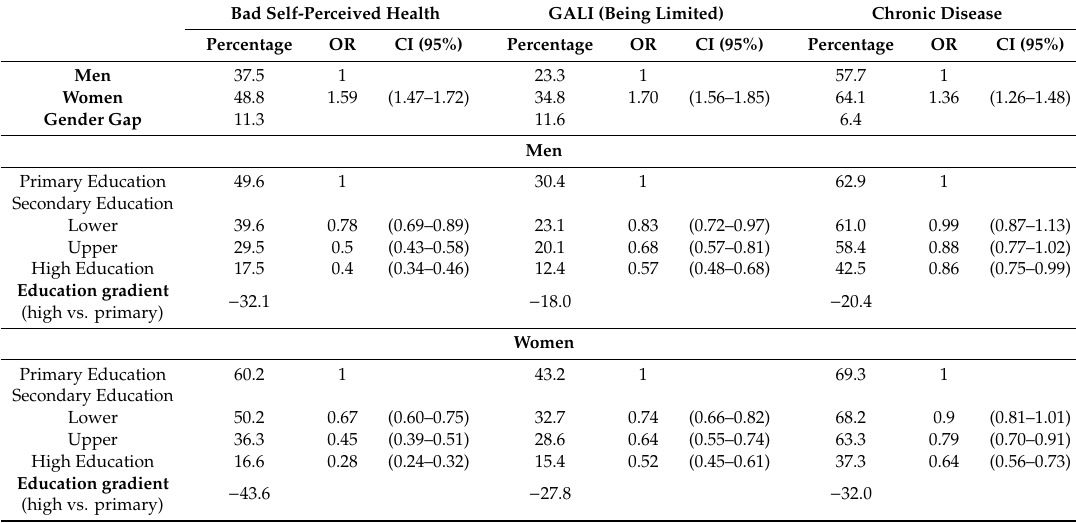
Table 2. Age-adjusted prevalence of reporting bad health (three health status measures) for men and women by education level. GALI is the global activity limitation indicator; odds ratios (OR) for poor health indicates the e ff ect of being female and education level for men and women, adjusted by age (for age 50). Bad Self-Perceived Health GALI (Being Limited) Chronic Disease Percentage OR CI (95%) Percentage OR CI (95%)